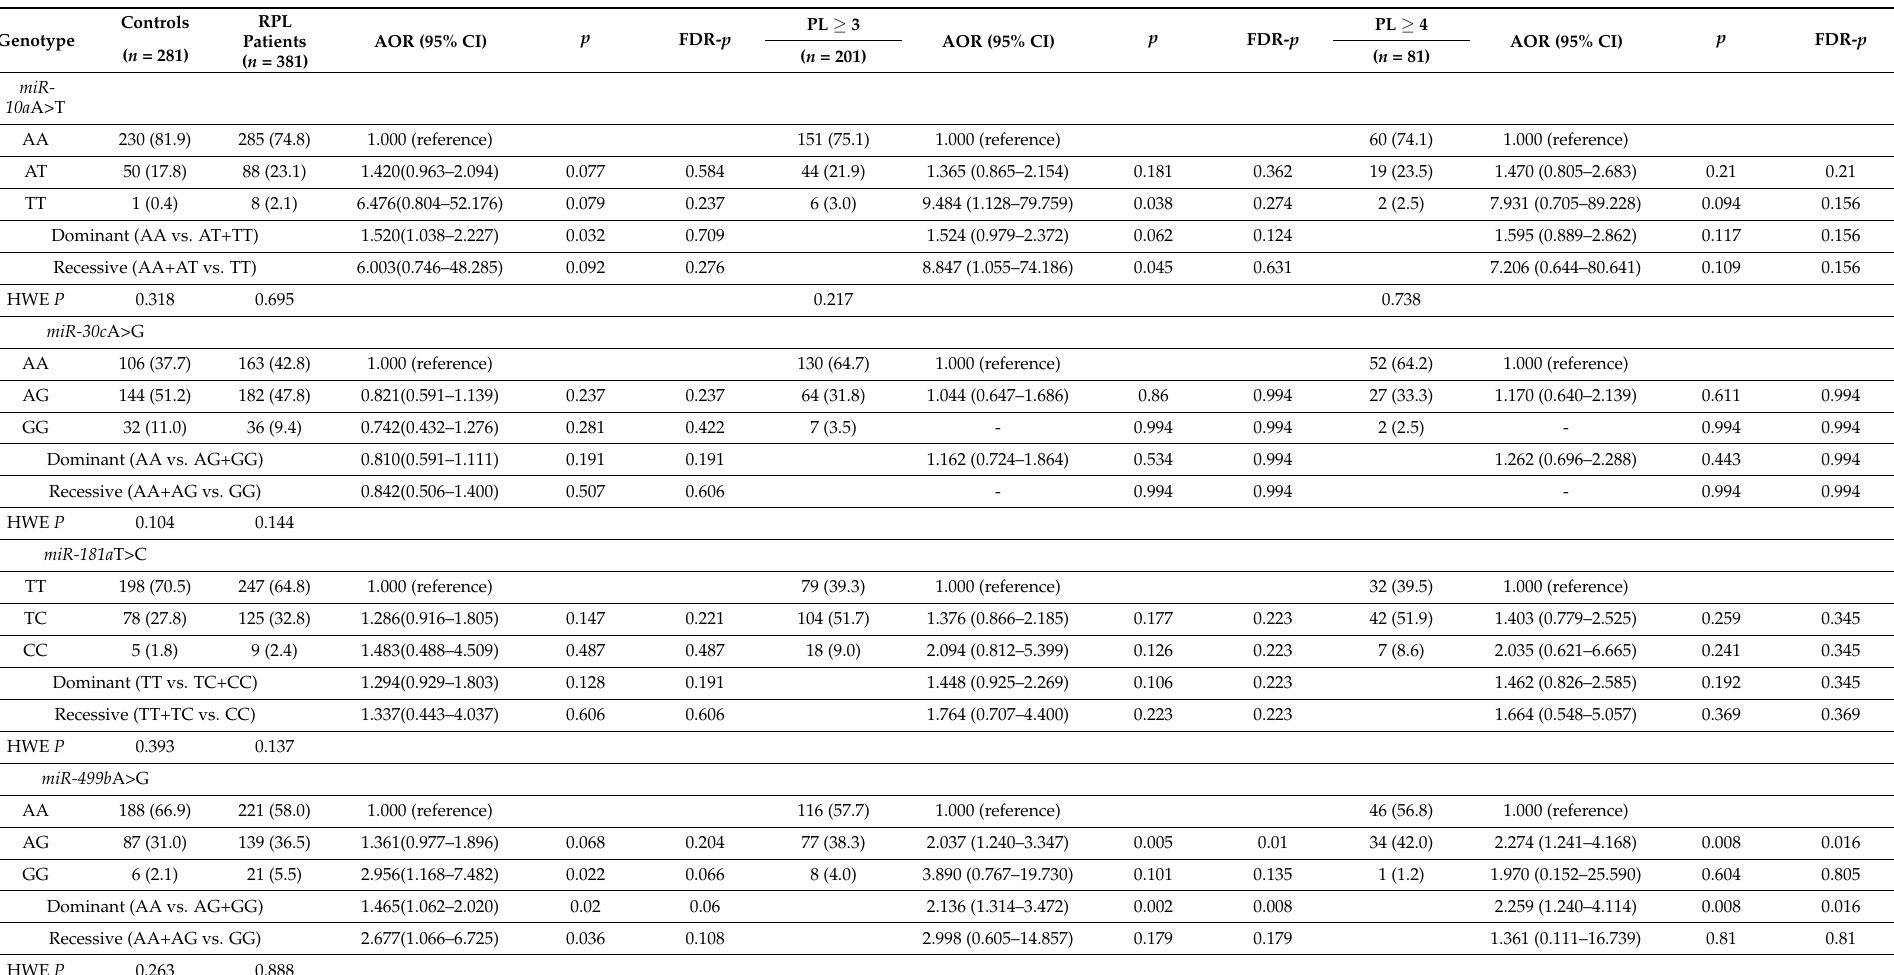
Table 2. Genotype frequencies of miRNA gene polymorphisms in control subjects and recurrent pregnancy loss